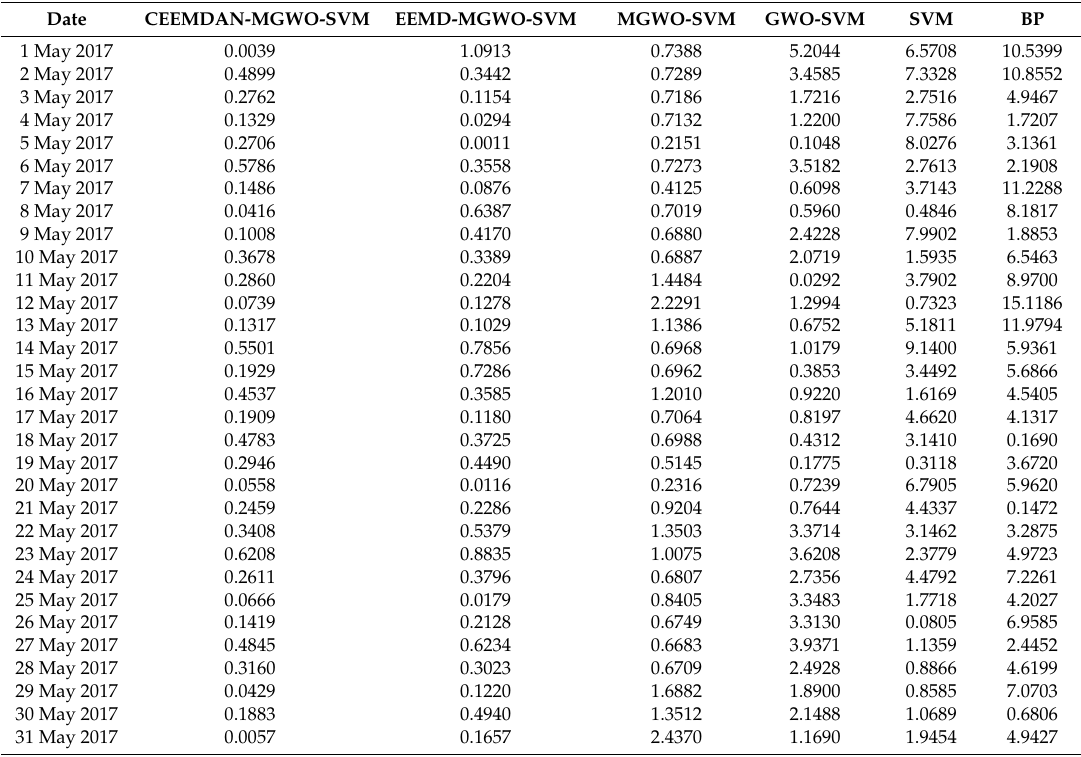
Table 8. The relative errors of the forecasting results for different models.